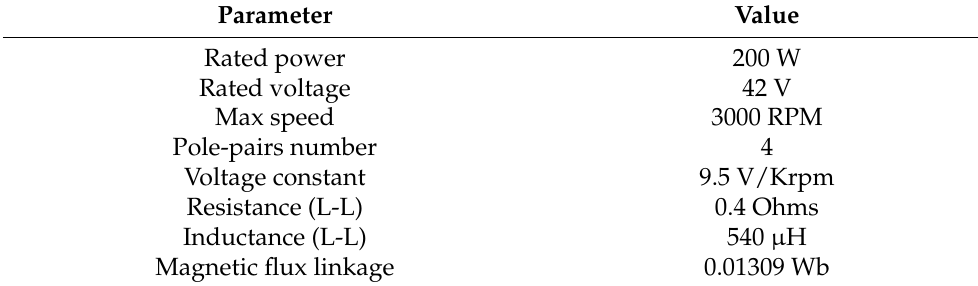
Table 1. PMSM specifications.